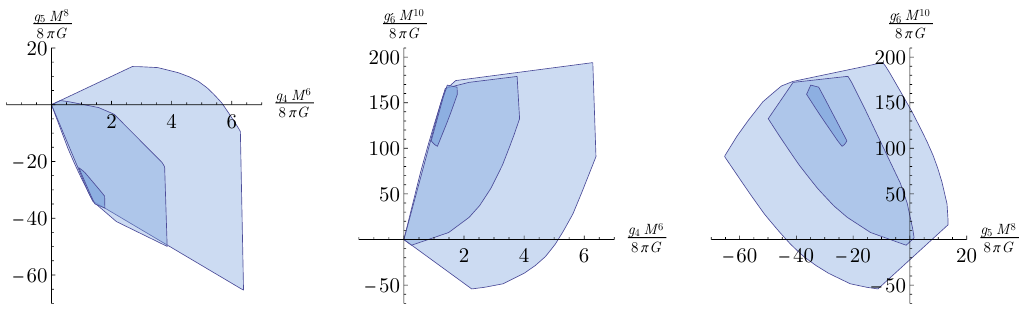
Figure 7 . Bounds on the higher-dimension contact coefficients g 4 , g 5 , g 0 in D = 6 . We com- 6 pute bounds that are independent of g 3 by restricting to the subspace of functionals whose EFT contribution is independent of g 3 . We compute the 3-dimensional allowed region in ( g 4 , g 5 , g 0 ) - 6 space for a few example values of g 2 , and then project onto pairs of axes for display. The values of g 2 shown here are g 2 = 0 (lightest blue), g 2 M 2 = − 5 (medium blue), g 2 M 2 = − 9 (darkest 8 πG 8 πG blue). These bounds were computed using the same parameters and functionals listed in column 1 of table 2, with the additional functionals C improved × { p 0 , p 1 , . . . , p 5 } . When g 2 approaches the 4 , − p 2 “tip of the cone” at its minimum value g 2 M 2 / (8 πG ) ≈ − 9 . 6 , the allowed region shrinks towards (cid:16) (cid:17) 0 10 g 4 M 6 , g 5 M 8 , g ≈ (1 . 4 , − 34 , 165) 6 M 8 πG 8 πG 8 πG